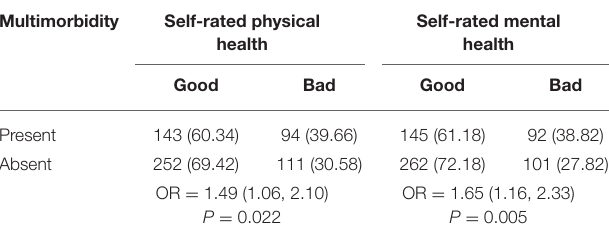
TABLE 4 | Association of multimorbidity with self-rated health.